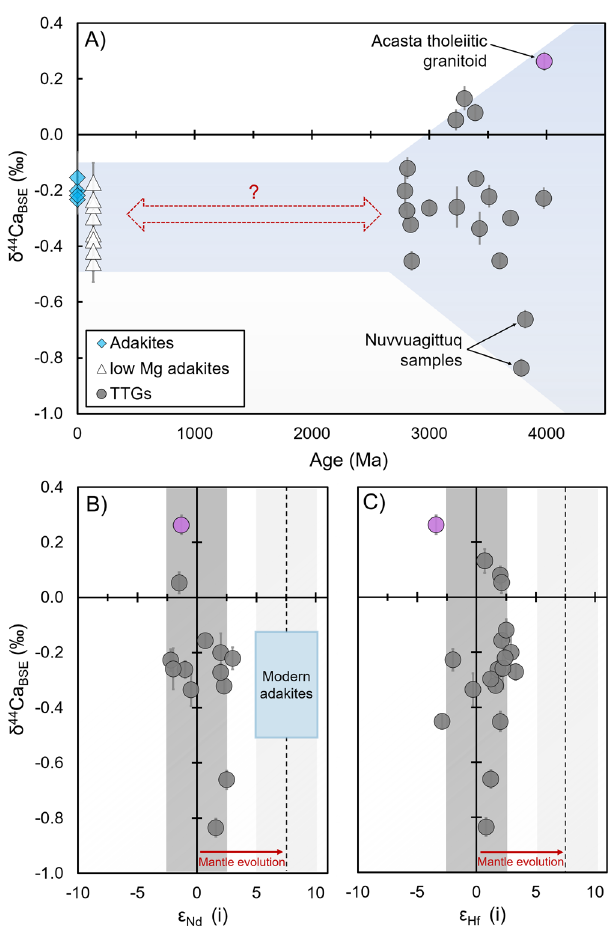
Fig. 1 Ca isotope data through time and initial radiogenic isotope values 11 for our samples. A δ 44 Ca vs. age for TTG/adakite samples and Acasta tholeiitic granitoid (pink circle) analyzed in this study and low Mg adakites 15 ( n = 32). B δ 44 Ca vs. initial ε Nd ( n = 13) for Archean samples. C δ 44 Ca vs. initial ε Hf ( n = 19) for Archean samples. The mantle-like isotopic signatures suggest that assimilation of pre-existing crust was not an important process in our samples. Error bars represent 2SE uncertainties on our Ca isotope measurements. TTG tonalite – trondjhemite – granodiorite